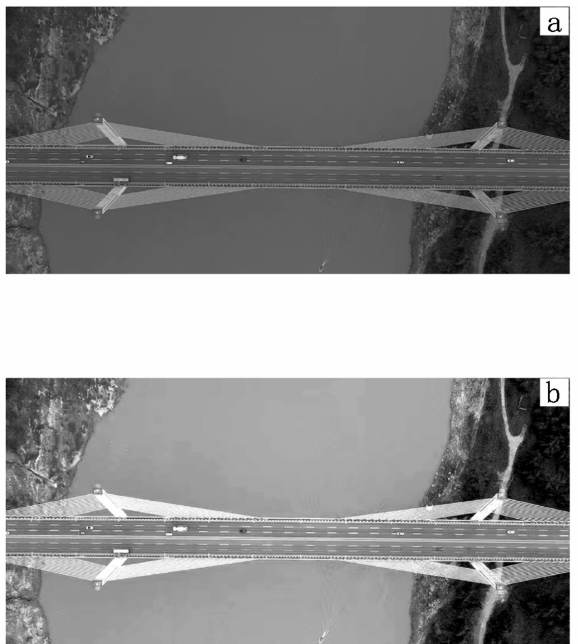
Figure 5. ( a ) Original image. ( b ) Enhanced greyscale